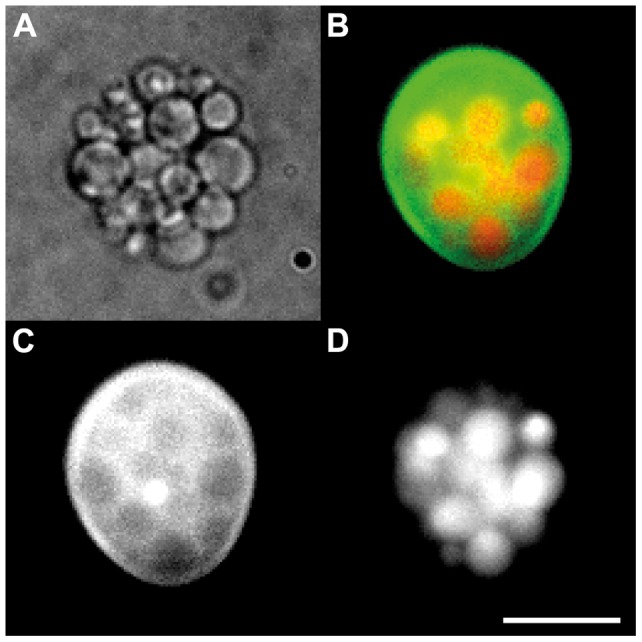
Transmission and fluorescence micrographs of a representative intact hierarchical unilamellar vesicle.A) The unilamellar fluorescently labeled phospholipid membrane confining the densely packed encapsulated giant unilamellar vesicles (GUVs) is only visible in the fluorescence micrographs B and C. B) Image overlay of C) indicating the envelope membrane labeled green and D) indicating the encapsulated GUVs, the lumen of which is labeled red. Scale bar: 10 μm.